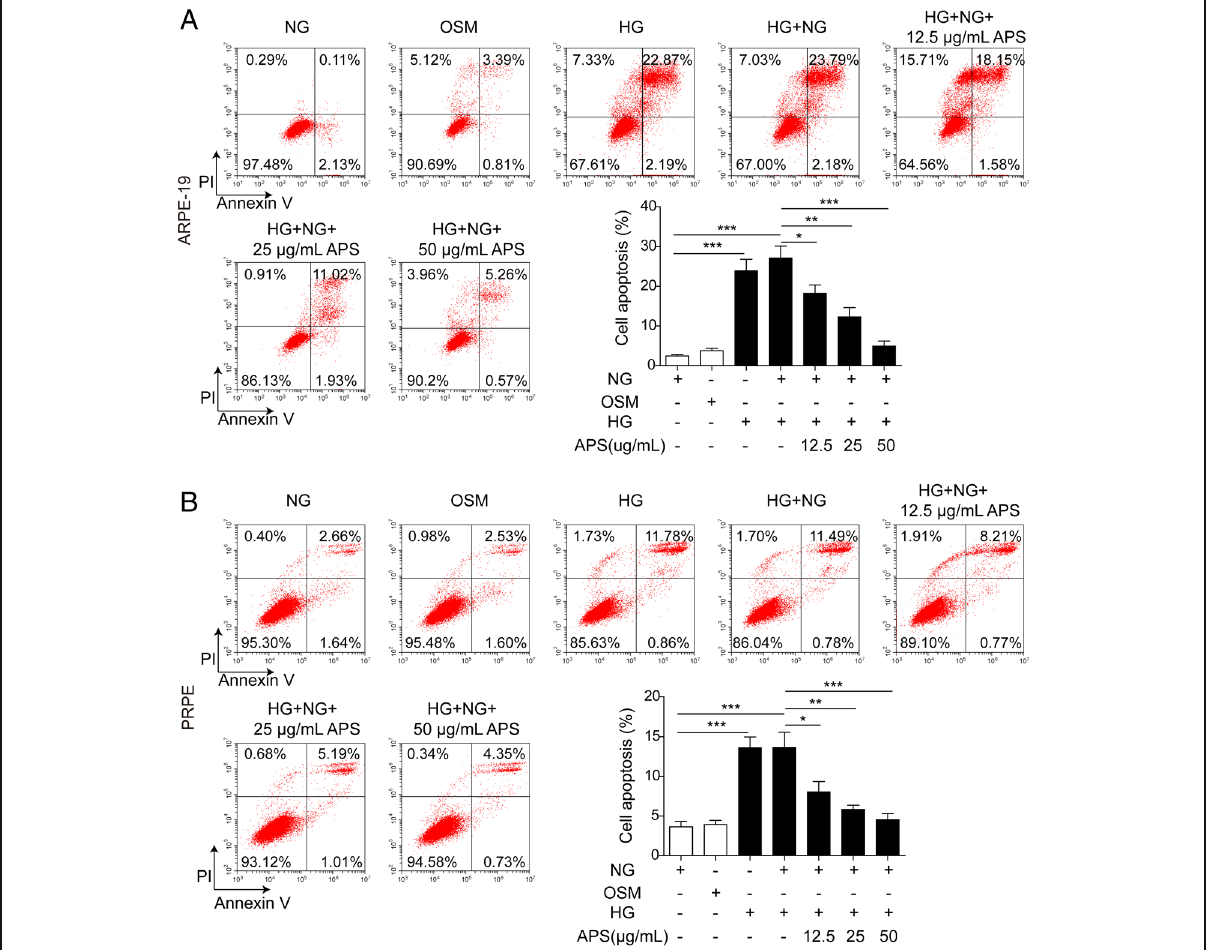
Fig. 6 APS rescued the apoptosis in metabolic memory model by flow cytometry. a Flow cytometry showed treatment with APS significantly decreased the cell apoptosis induced by HG and HG + NG treatment in APRE-19 cells. b Flow cytometry showed treatment with APS significantly decreased the cell apoptosis induced by HG and HG + NG treatment in PRPE cells. Error bars represented mean ± SD. *** p < 0.001, ** p < 0.01, * p <